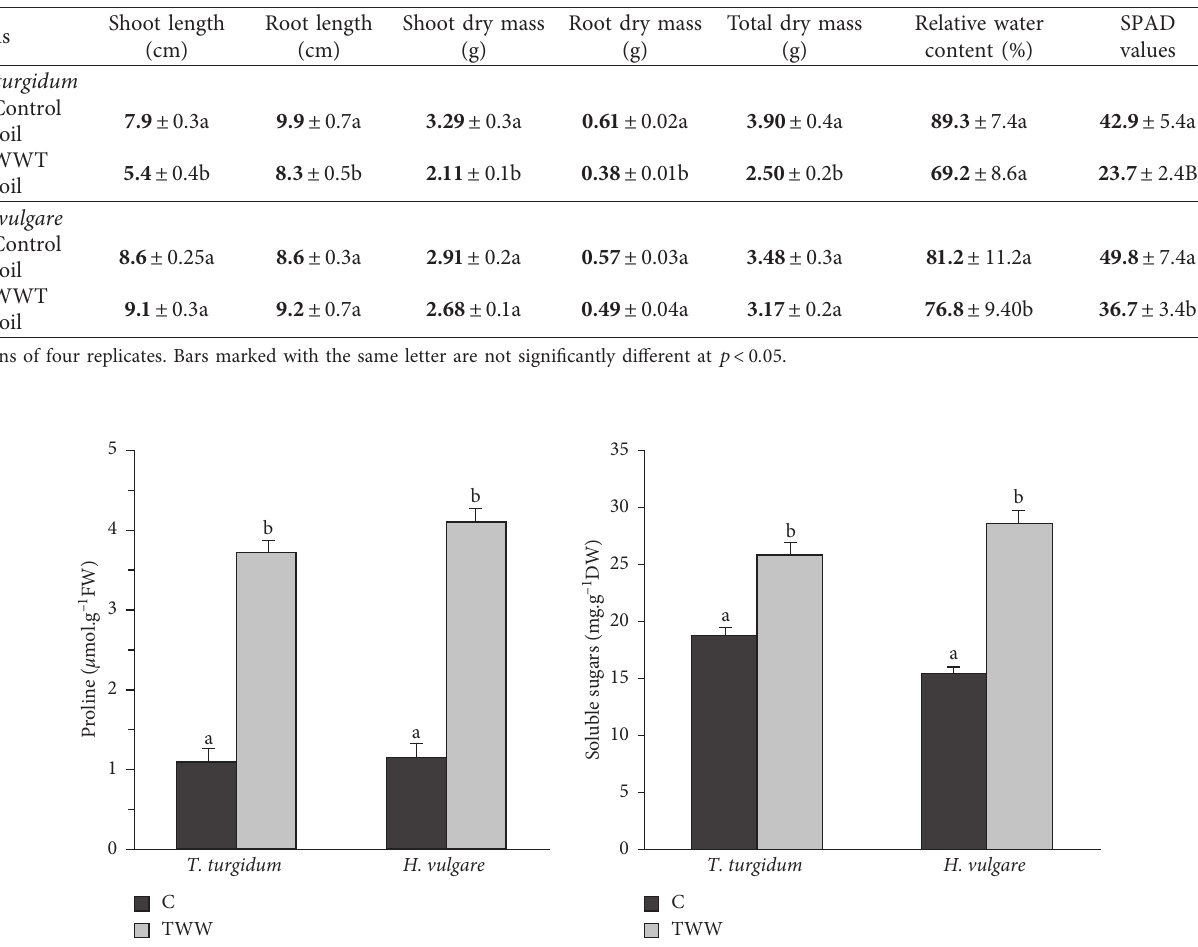
Table 2: Lengths of shoots and roots and dry biomass of durum wheat and barley on control soil and soil irrigated with wastewater from the pumping water treatment station of CRDA